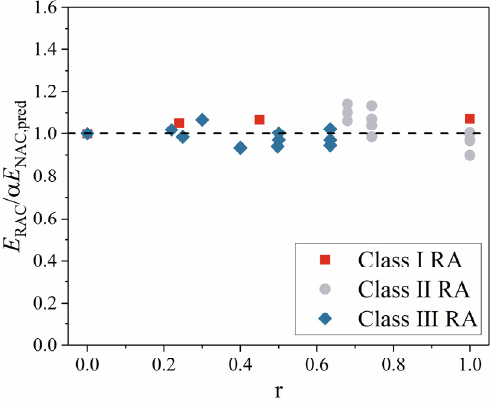
Figure 3. Comparison of elastic moduli of RAC designed by EMV method and NAC of equal strength [86,93,101,111,115,120,126,168].